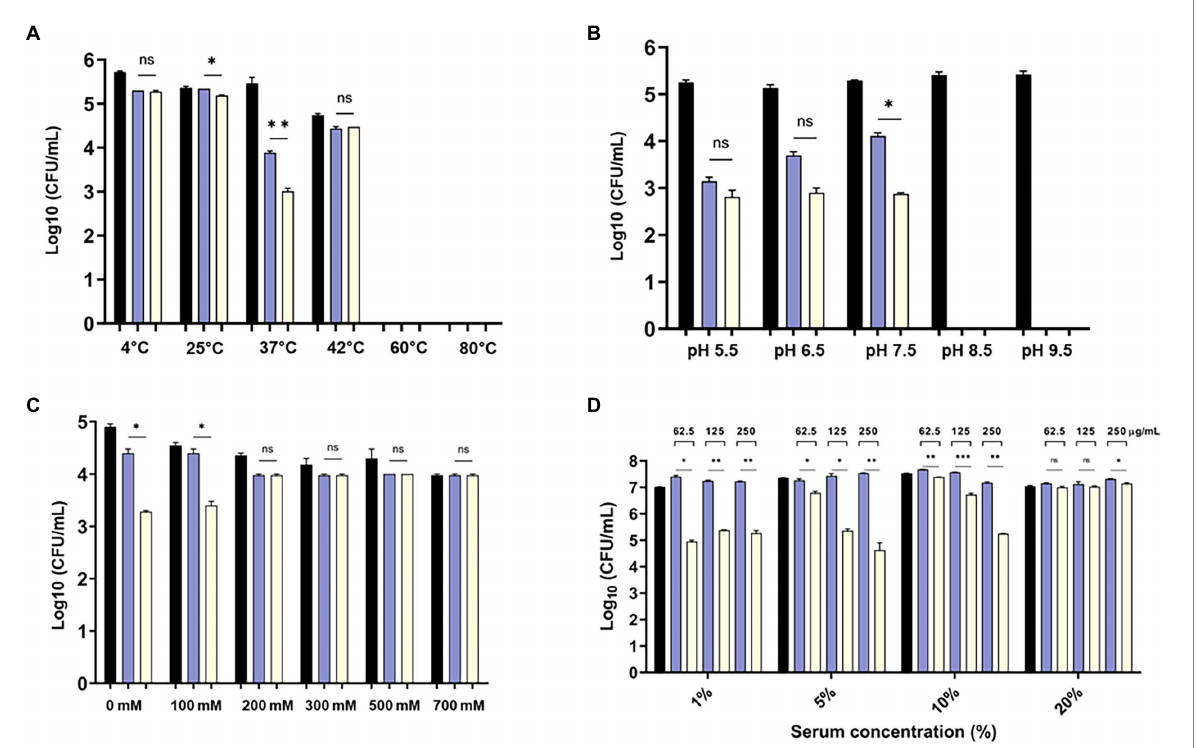
FIGURE 4 Effect of temperature, pH, salinity and human serum on the lytic activity of eAbEndolysin. (A) Effect of temperature on AbEndolysin and eAbEndolysin stability after incubation at 4–80 ° C. (B) Effect of pH values on AbEndolysin and eAbEndolysin activity after incubation at pH 5.5–9.5. (C) Effect of salinity on AbEndolysin and eAbEndolysin activity in 0–700 mM/l NaCl solutions. (D) Activity of AbEndolysin and eAbEndolysin in presence of human serum (1–20%). The number of log10 CFU/mL was determined through plating 10-fold serial dilution in a bactericidal assay. Data are expressed as the mean ± SD. Experiments were performed independently in duplicate. Statistical significance was determined by t-test. ( * p < 0.05; ** p < 0.01; *** p < 0.001 and ns- not significant). Black indicate untreated endolysin, sky blue indicate treatment with AbEndolysin and yellow indicate treatment with